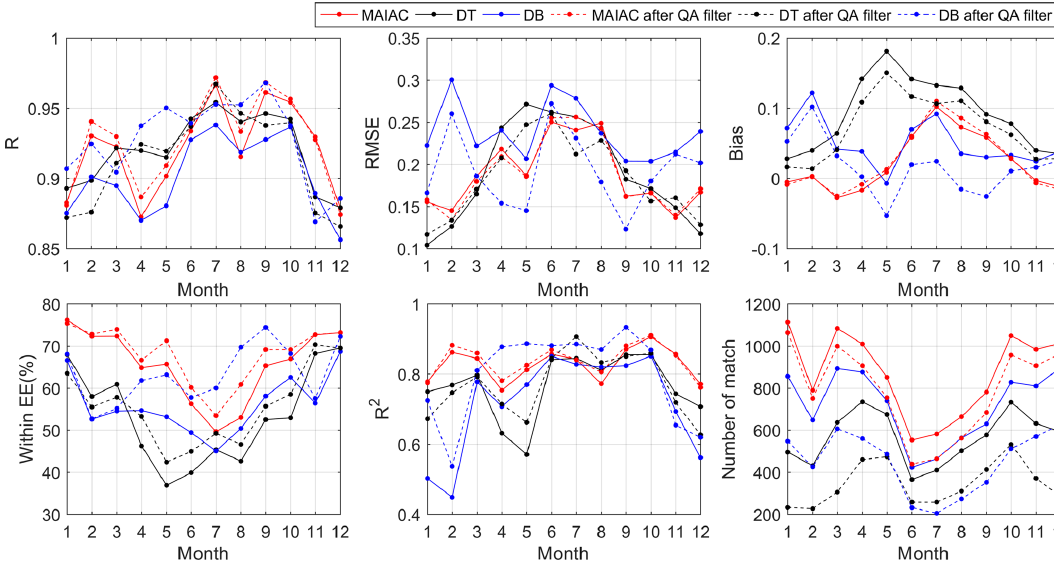
Figure 10. Validation of MAIAC, DT, and DB in different months before and after the QA filter.